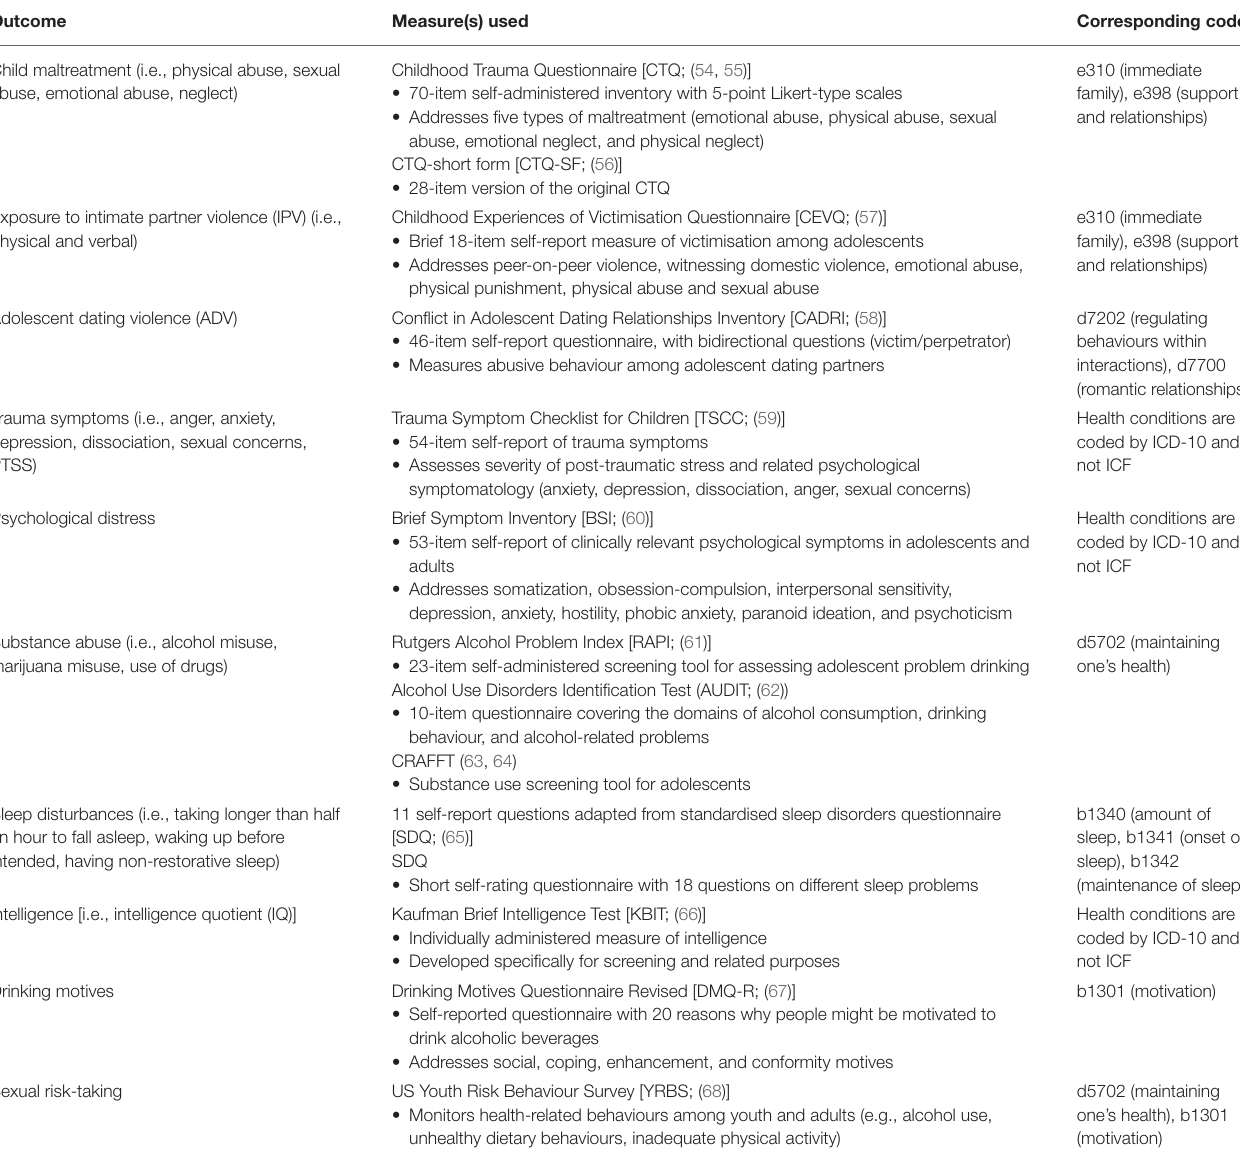
TABLE 2 | MAP study measures. Outcome Measure(s)